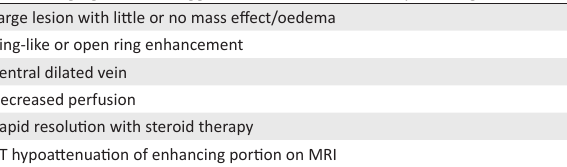
FIGURE 7: MR spectroscopy image obtained at TE 135 ms. BOX 1: Imaging features suggestive of Tumefactive demyelinating